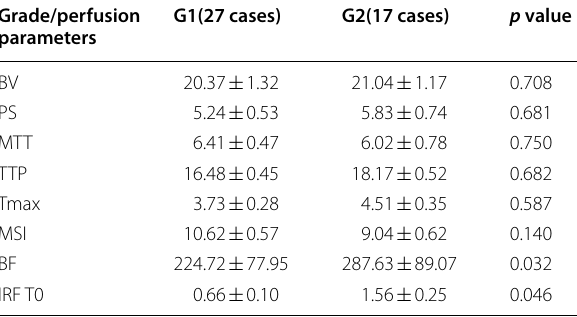
Table 4 Comparison of perfusion parameters between